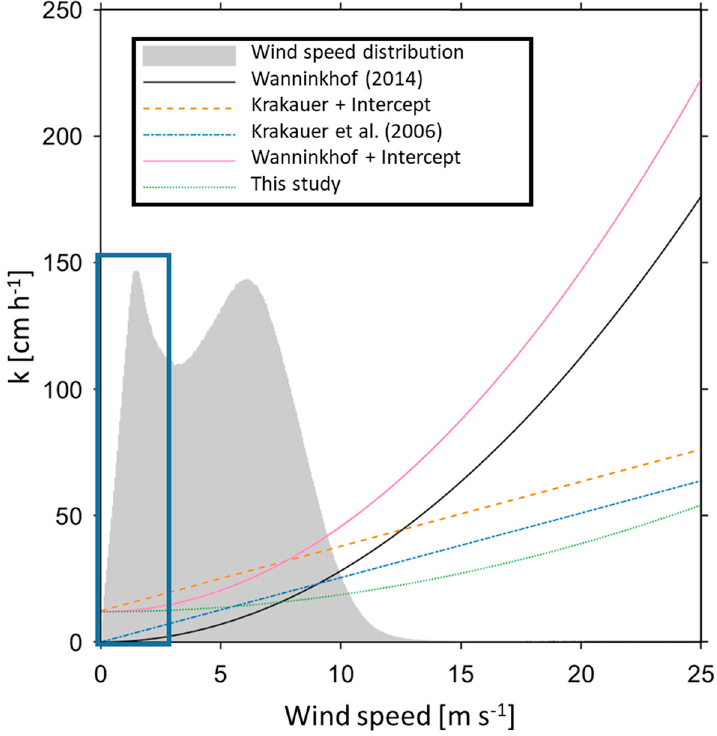
Figure 7. Same as Figure 6 but containing the wind histogram from the Tropics from the year 2000.